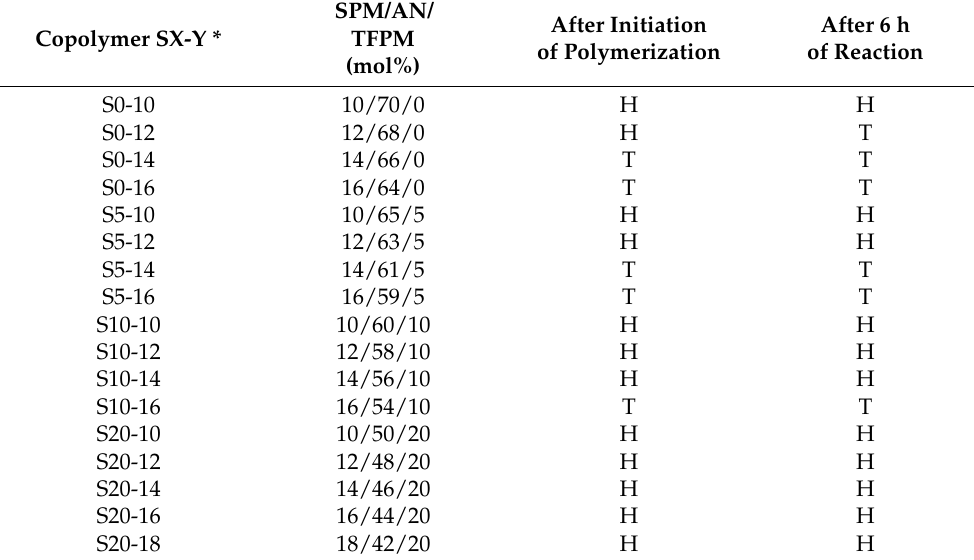
Table 1. Phase separation behavior in the copolymerization of SX-Y random ionomers and resulting SX-Y